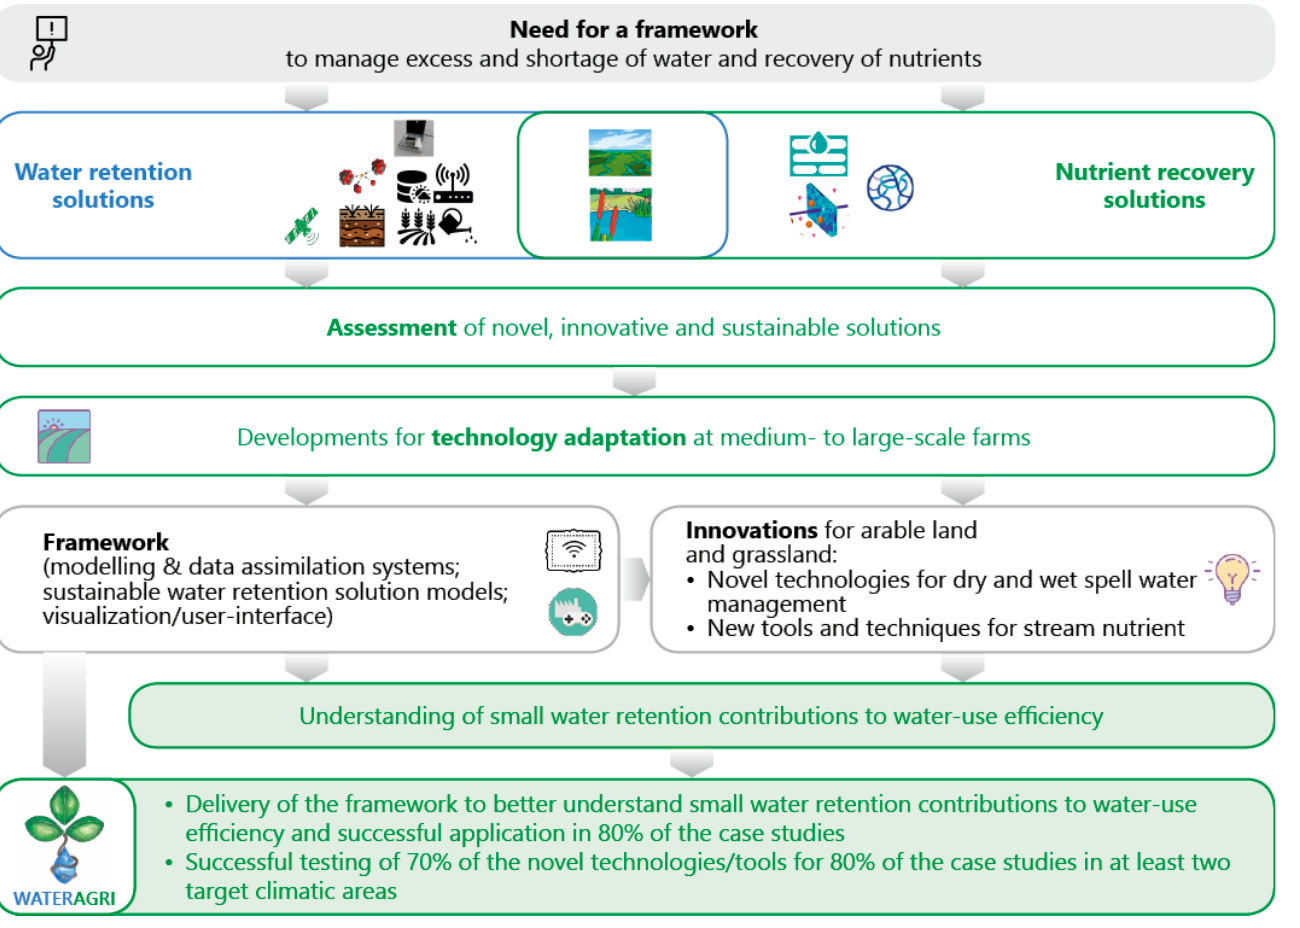
Figure 1. Methodological WATERAGRI concept outline of providing, assessing and adapting sustainable solutions for farmers in order to improve water and nutrient management.